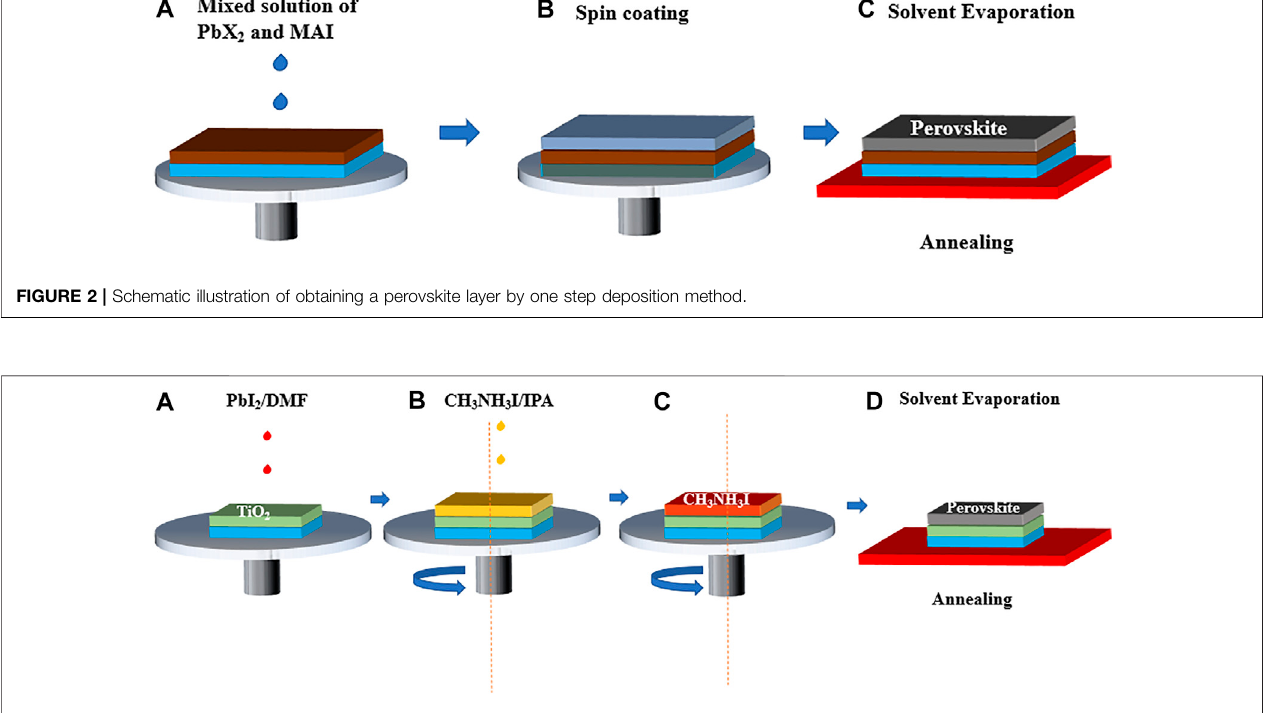
FIGURE 3 | Schematic diagram of obtaining a perovskite layer by two-step spin coating method.